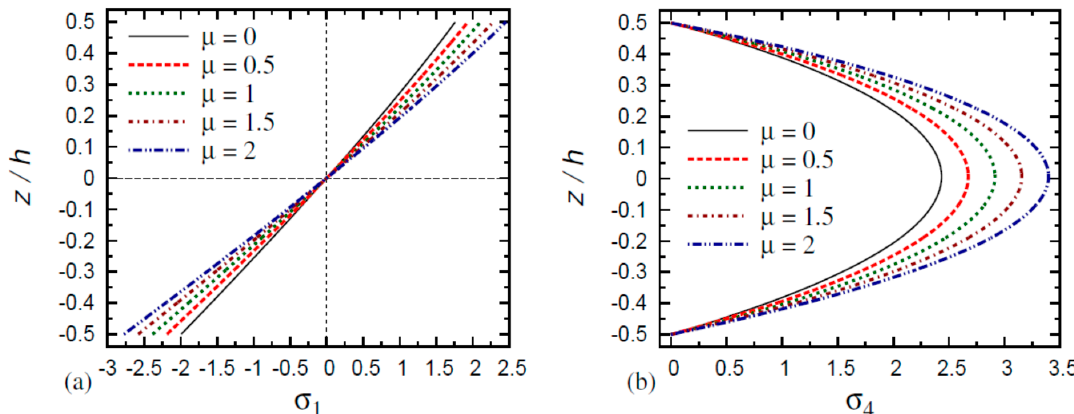
Figure 7. The through the thickness distributions of the stresses in FG square nanoplates for different values of small length scale (cid:2020) . ( a ) The in-plane stress (cid:2026) (cid:2869) and ( b ) the shear stress (cid:2026) (cid:2872) ( (cid:1863) = 1 , (cid:1853)/ℎ = 10 ).